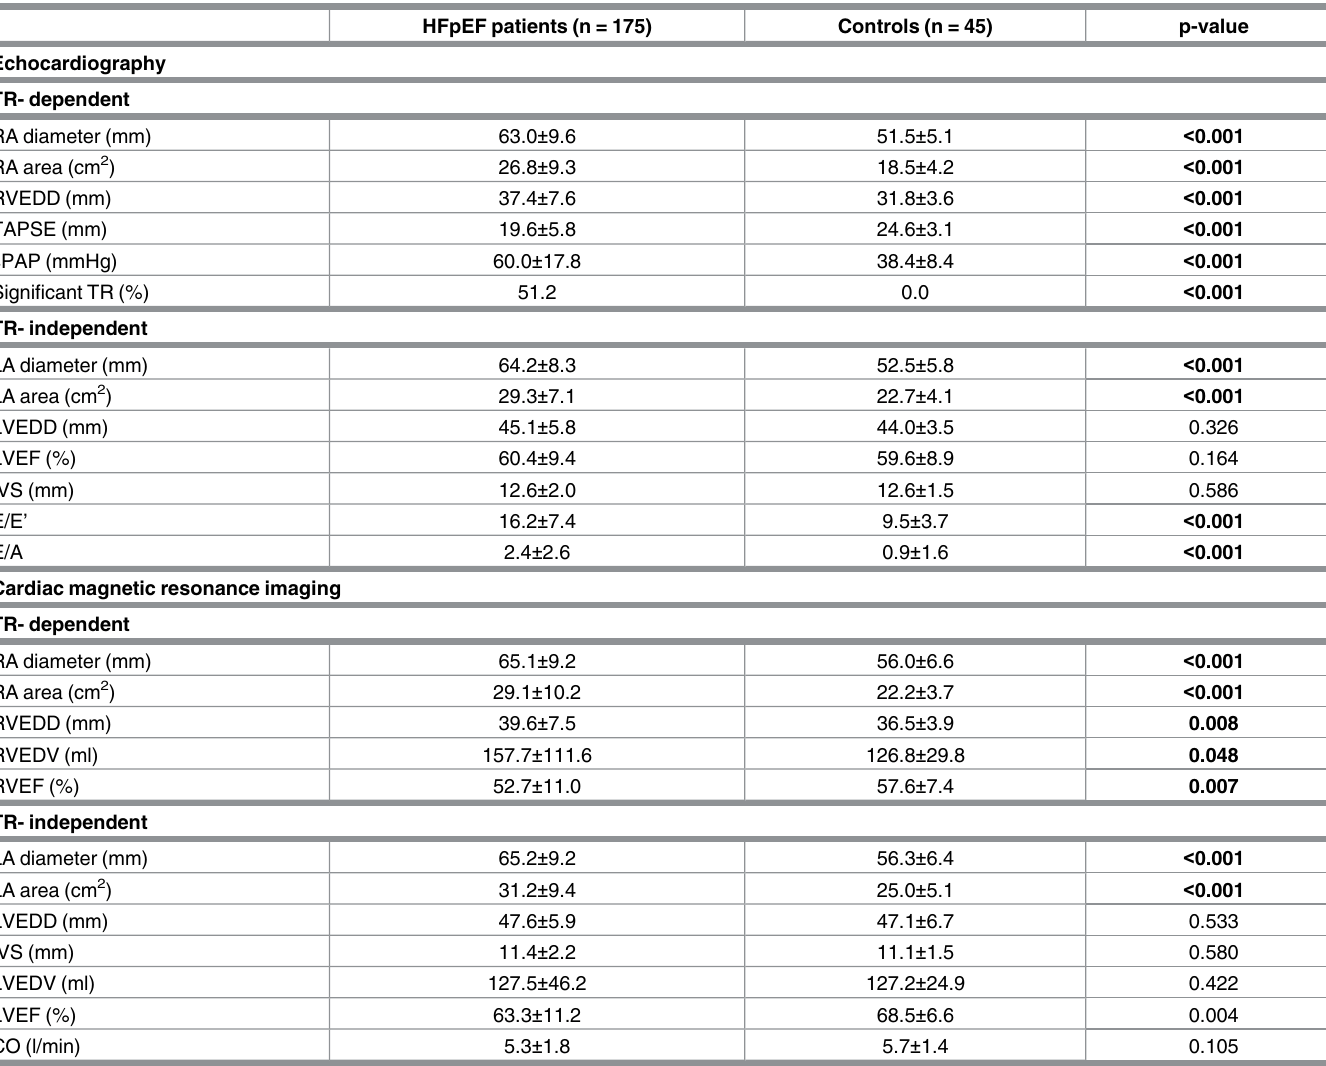
Table 3. Baseline imaging characteristics of HFpEF patients and